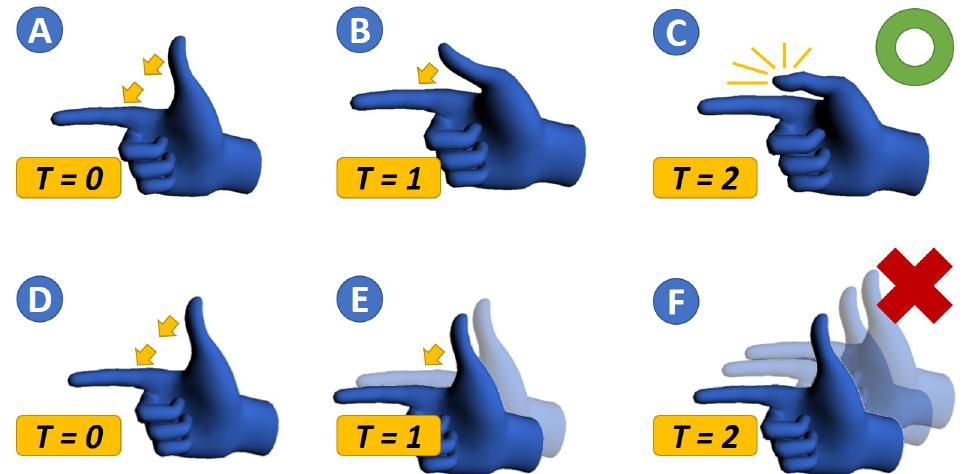
Figure 4. Images ( A – C ) show the desired behavior for performing a “pistol” gesture. ( D – F ) shows wrong movement that is still accepted by the system if no proper constraints are applied. In this case, the user follows the gesture path by moving the whole hand instead of only the thumb. This can be solved by applying constraints to the palm position of the